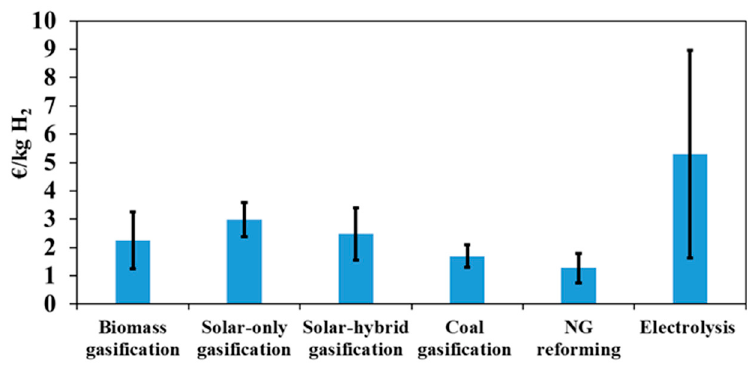
Figure 10. Hydrogen production cost and sensitivity on the primary resource cost (electricity for electrolysis) when ranging from zero to twice the reference cost (Table 4).